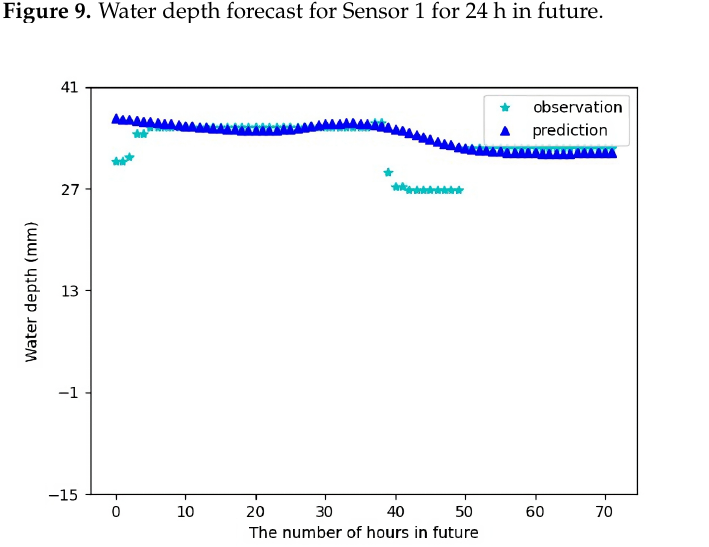
Figure 10. Water depth forecast for Sensor 1 for 72 h in